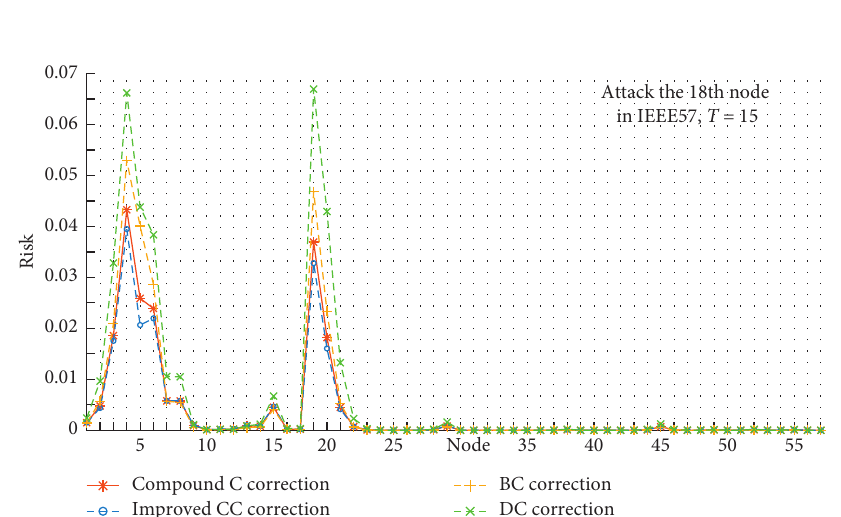
Figure 7: Risk of node under compound C, improved CC, BC, and DC correction at T � 15.